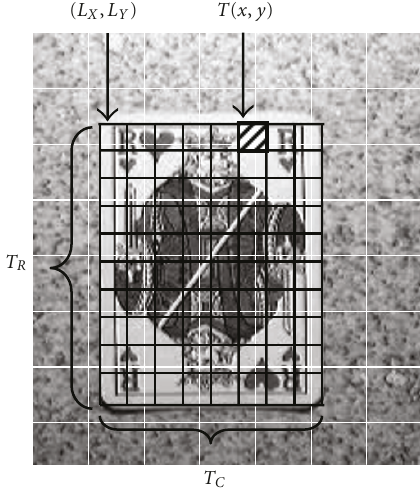
Figure 3: A part of a frame where the card is selected as the ROI. T 10. An element of the The ROI mask has dimensions T C R = 8 (cid:0) (cid:0) ROI mask is notated as T ( x , y ). The upper left corner of the ROI mask has the coordinates ( L X , L Y ). The ROI mask is a floating layer on top of the frame and it is not aligned to the boundaries of the macroblock (represented by the white